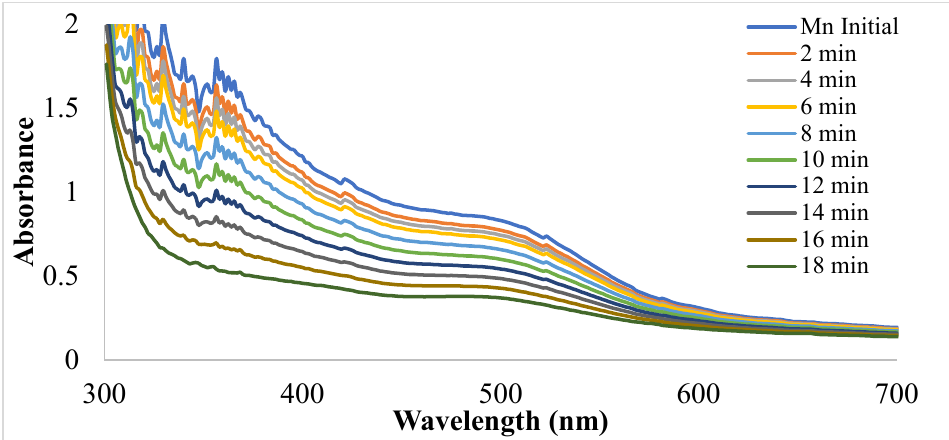
Figure 11. UV-visible spectra for photocatalytic degradation of CR using Mn NPs.